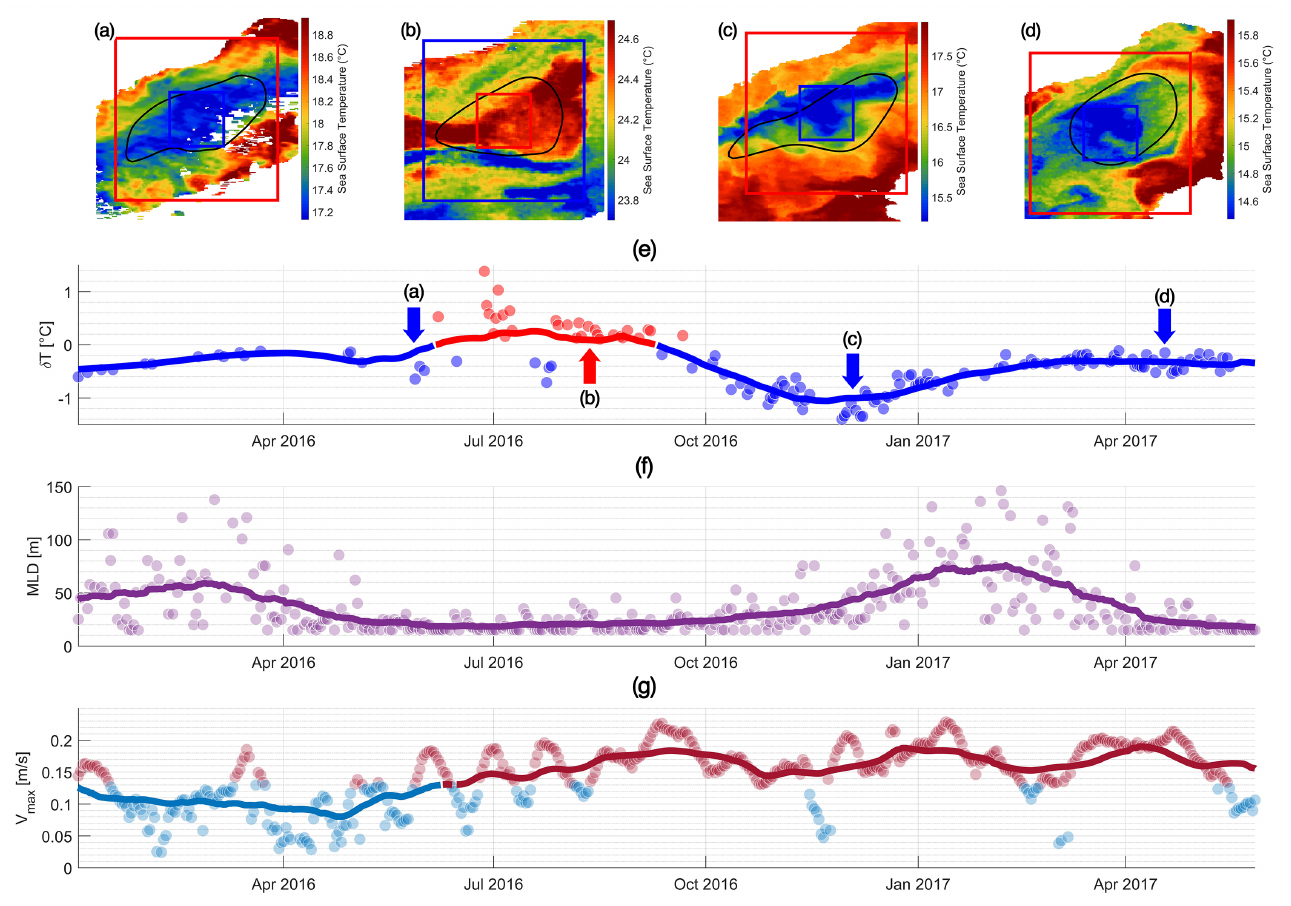
Figure A3. Timeline of the Liguria cyclone with DYNED ID #9784. Panels ( a – d ) show four character- istic SST patches corresponding with the δ T evolution in panel ( e ). Panel ( f ) shows the evolution of the MLD outside the eddy. Panel ( g ) shows the evolution of the maximal velocity. Lines represent the Monthly Mean Average of each variable. For more information, the reader is referred to Figure